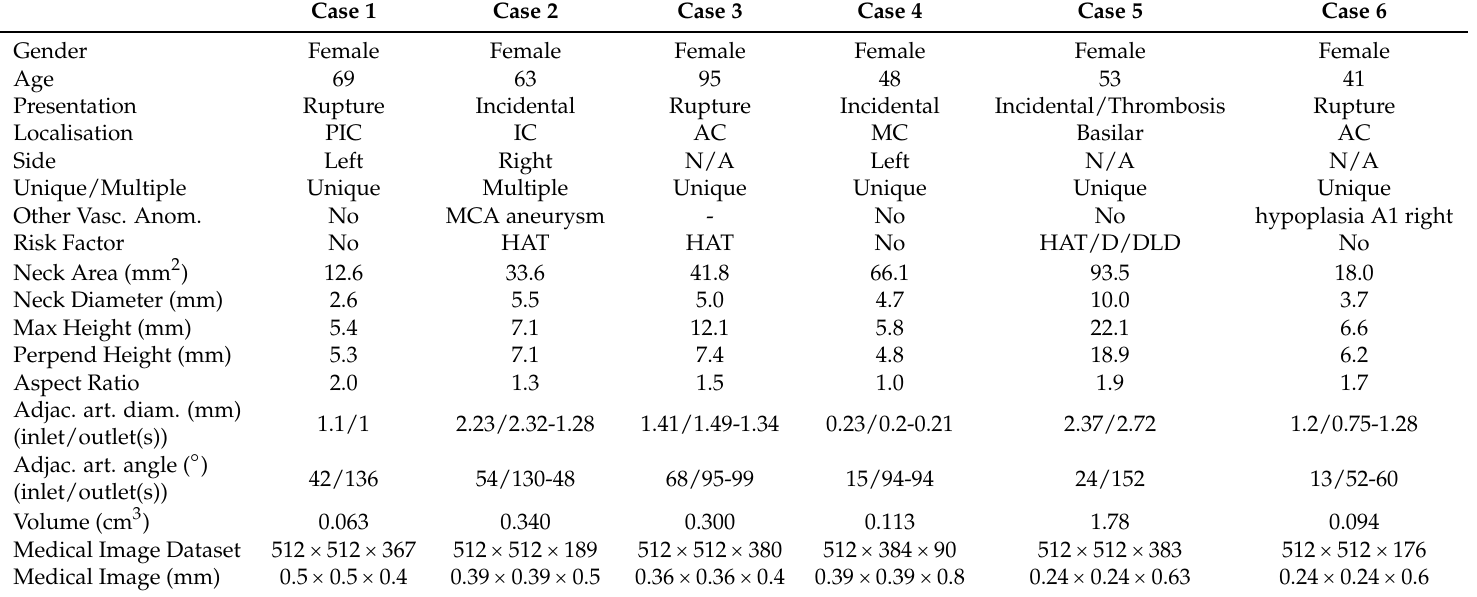
Table 1. Patient specific case